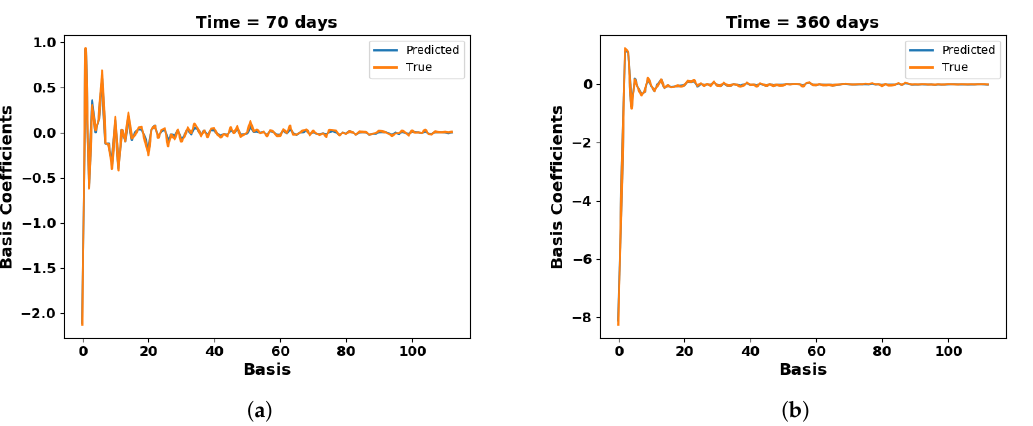
Figure 19. True and ML predicted saturation basis coefficient comparison at time = ( a ) 70 days and ( b ) 360